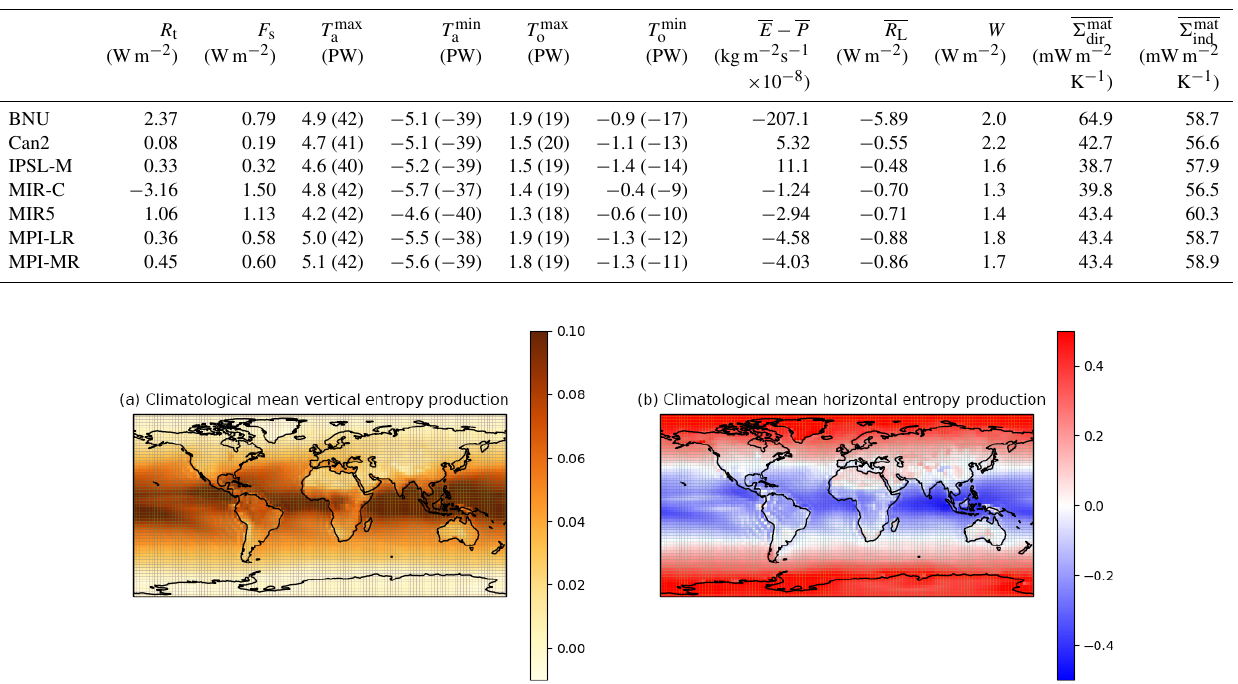
and (cid:54) mat , respectively). dir ind